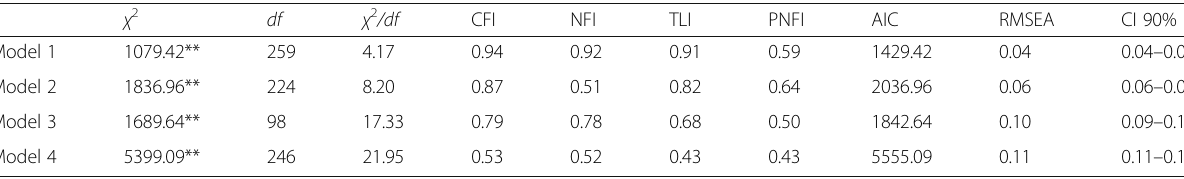
Table 2 Fit indices for the hypothesized model ( n =